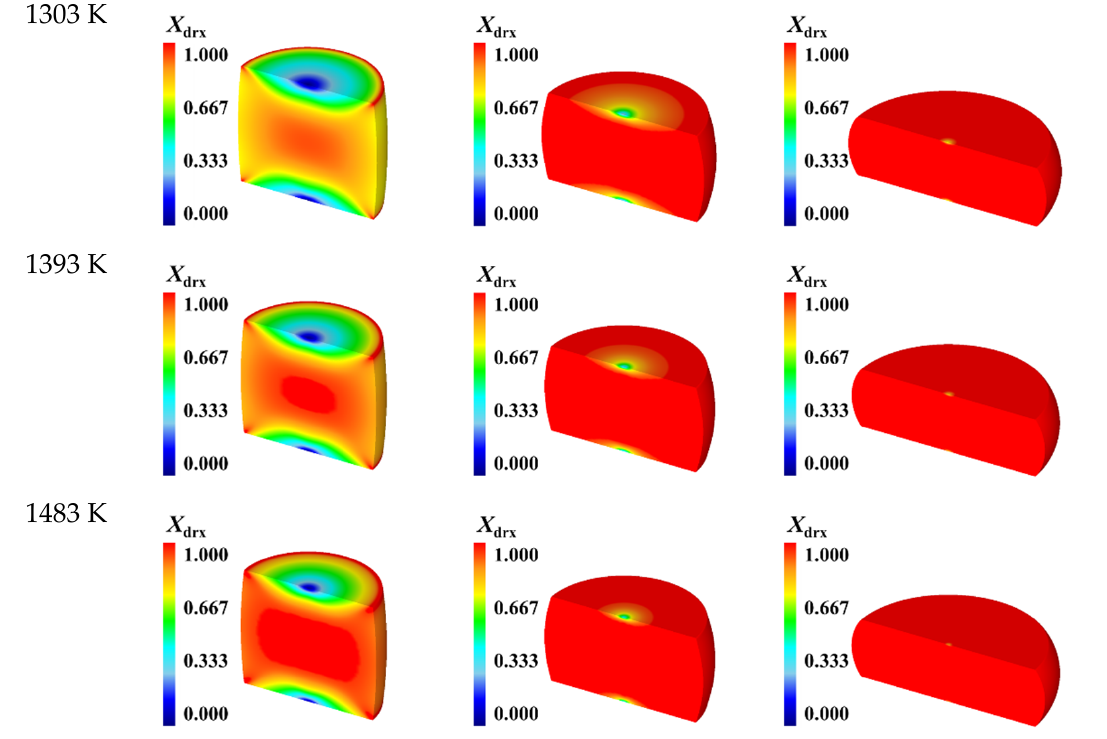
Figure 15. DRX volume fraction distributions of the specimens compressed to different true strains under the strain rate of 0.1 s − 1 and different temperatures of 1123–1483 K.